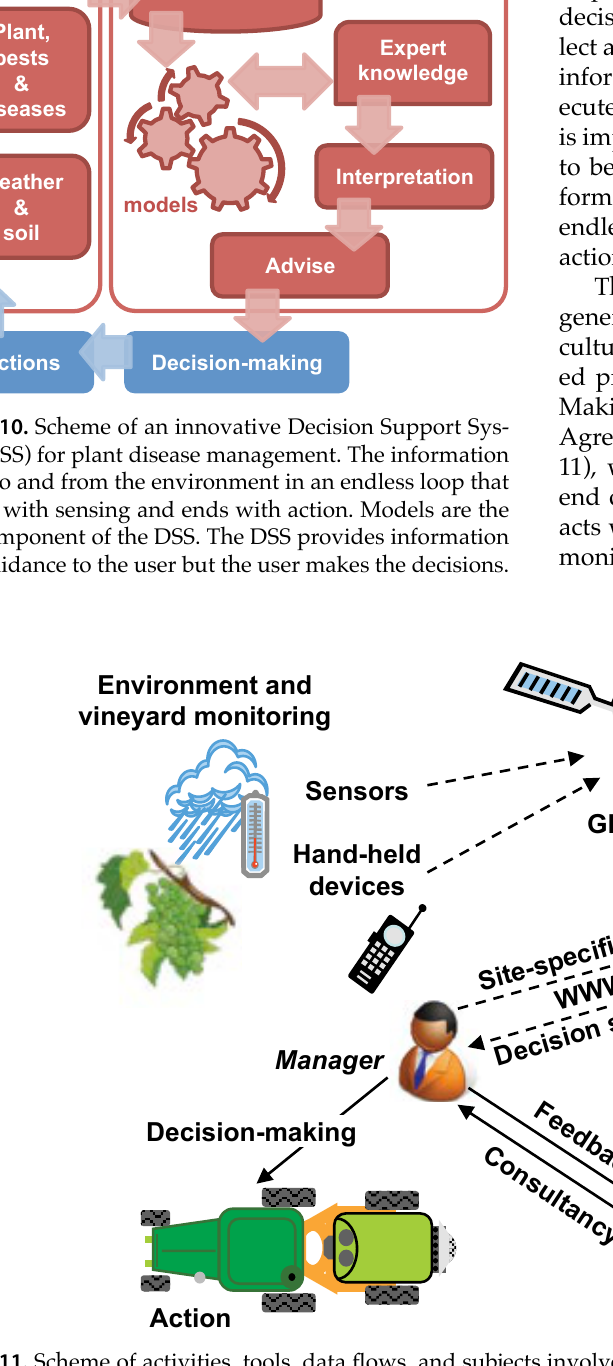
Figure 11. Scheme of activities, tools, data flows, and subjects involved in the development of a Decision Support System (DSS) for integrated management of vineyards, as in the EU project MoDeM_IVM (Monitoring and Decision Making in Integrated Vineyard